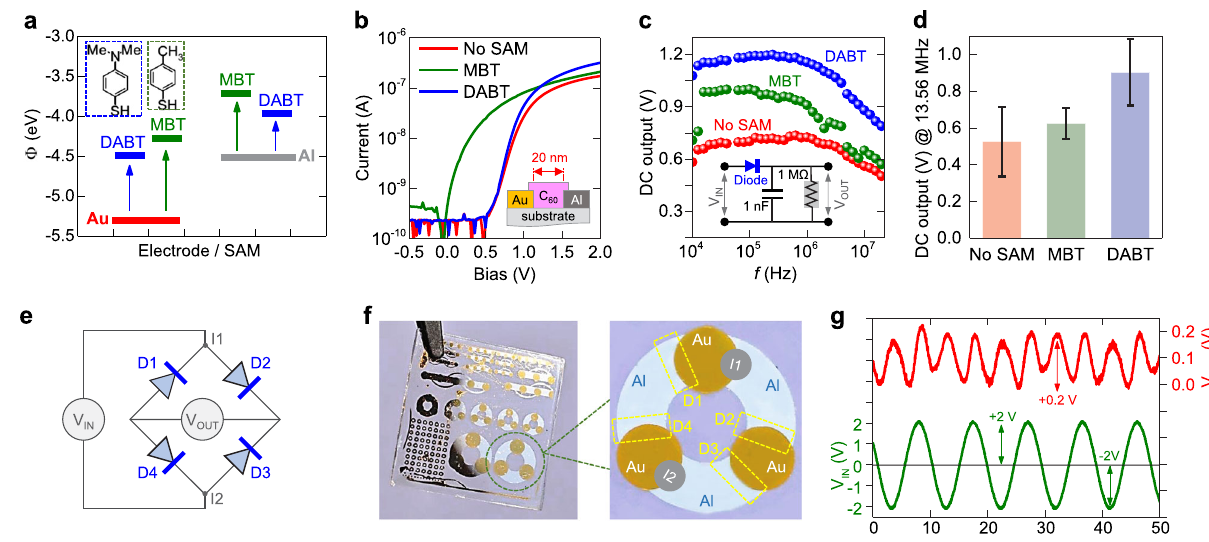
Fig. 3 RF diodes and monolithic full-wave rectifying bridges fabricated via a-Lith. a Work function of Au and Al electrodes before and after treatment with DABT and MBT SAMs. Inset: chemical structure of the DABT and MBT molecules. b Current – voltage characteristics of C 60 nanogap diodes with untreated (No SAM) and DABT- and MBT-treated electrodes. Inset: Schematic of device architecture. c DC output voltage ( V OUT ) as a function of input signal frequency ( f ) measured for C 60 diodes with untreated as well as DABT- and MBT-treated electrodes. The amplitude of the input signal used in this experiment was ± 3 V. Inset: Half-wave recti fi er (HWR) circuit. d Column chart of DC V OUT obtained from in total 45 diodes with different surface SAM treatments at 13.56 MHz input signal frequency. Error bars represent standard deviation. e Circuit schematic for a full-wave bridge recti fi er (FWBR). f Lower (left image) and higher (right image) magni fi cation photographs of the fabricated FWBR circuits. g V OUT measured for a full-wave recti fi er with a 100 Hz sinewave input signal ( V IN = ± 2 V